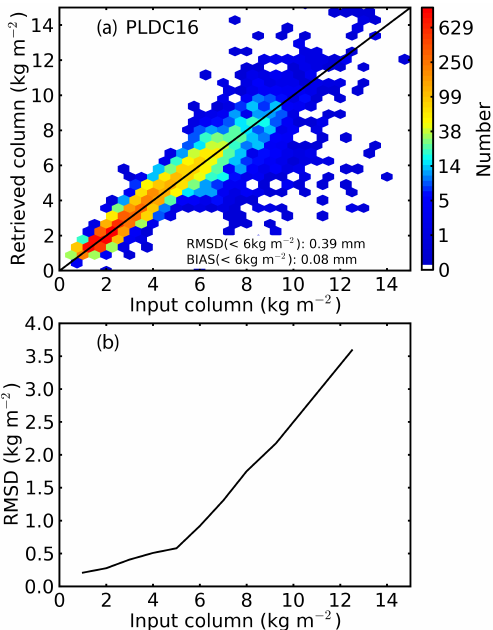
Figure 6. (a) PLDC16 retrieval of water vapour column from MHS brightness temperatures compared to GVR retrievals at Bar- row, Alaska. (b) The corresponding root mean square deviations